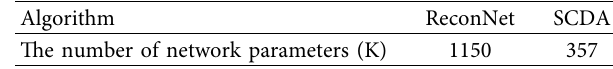
Table 7: The average time required for the reconstruction process (the measurement rate is 0.05).